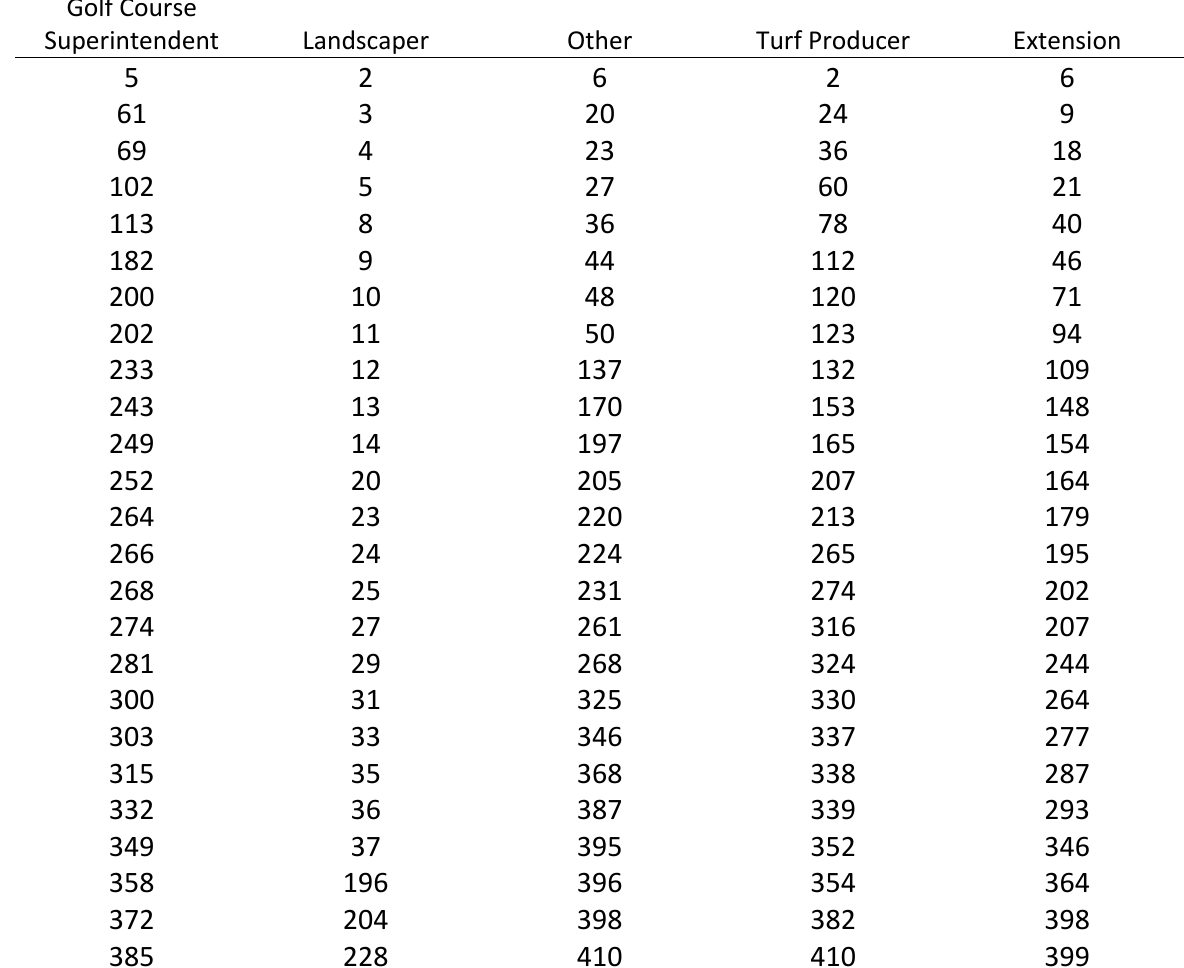
Table 3 Top 25 Key Players within Each Stratum Golf